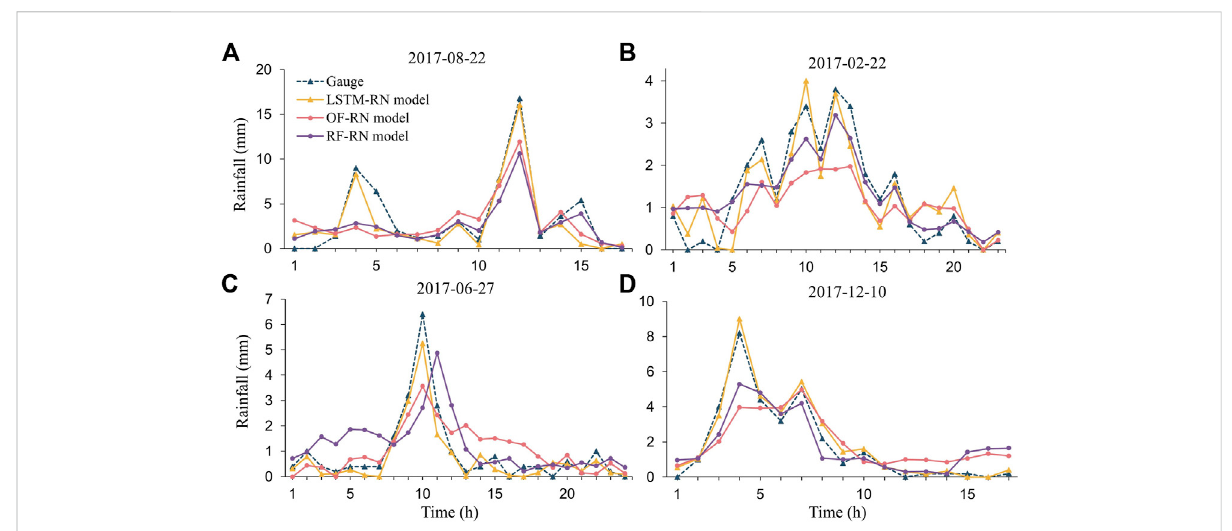
FIGURE 7 The gauge rainfall and the predicted results using three types of models of four rainfall events.